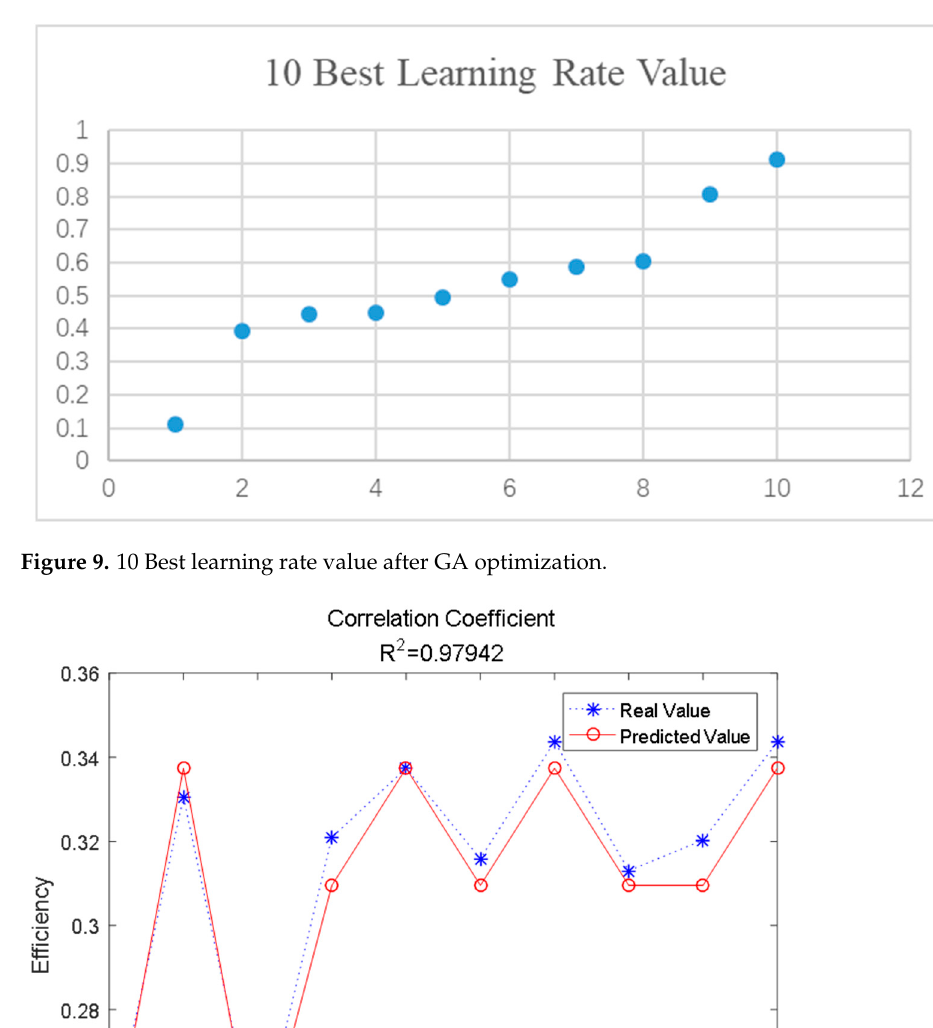
Figure 11. Efficiency predicted value by BP with learning rate optimization ( η = 0.4934). Comparing the above four results, we can make it clear that optimizing the learning rate increases good results of the data. While considering the measuring error and the random error, we introduce some random choice between BP datasets. After several times running the test, we obtained the best predicted value at minimum error. The BP algorithm with learning rate optimization results is showed in Figures 12 and 13.